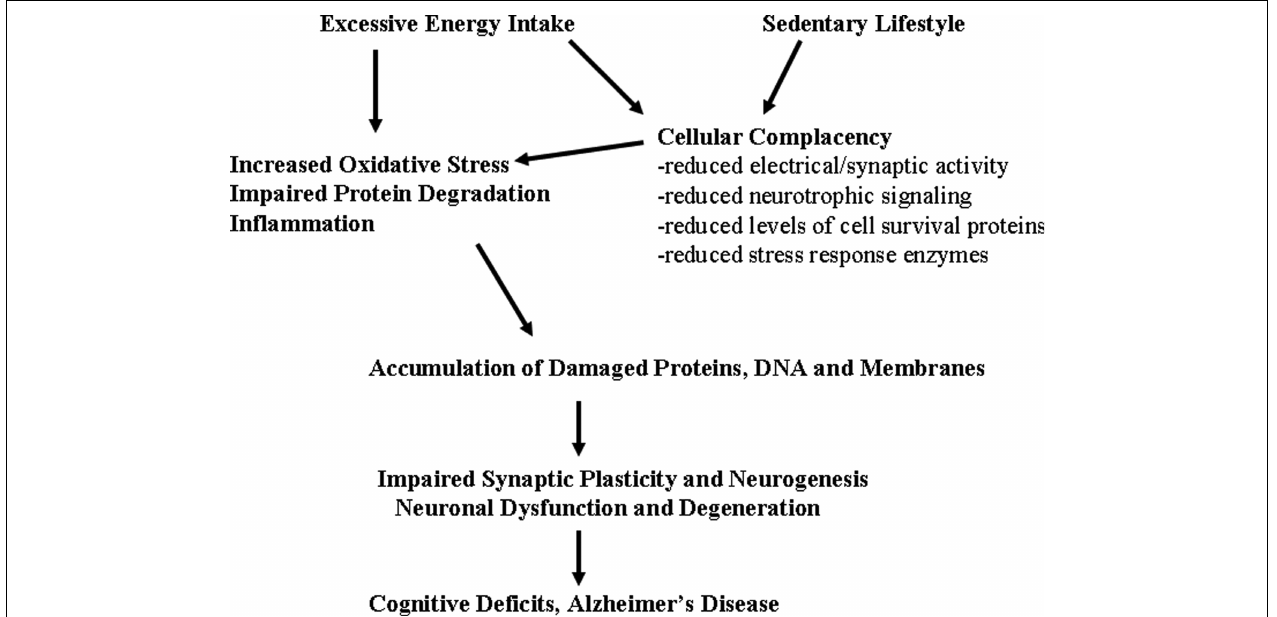
FIGURE 1 | Mechanisms by which excessive energy intake and low levels of energy expenditure adversely affect synaptic plasticity and cognitive function. Overeating adversely affects the brain because of the increased oxidative stress resulting from increased levels of glucose which may result in increased generation of superoxide anion radical in the mitochondria and a nonenzymatic process called glycation. Also contributing to increased molecular damage is the reduction in the activation of adaptive cellular stress response pathways (cellular complacency) which manifests as